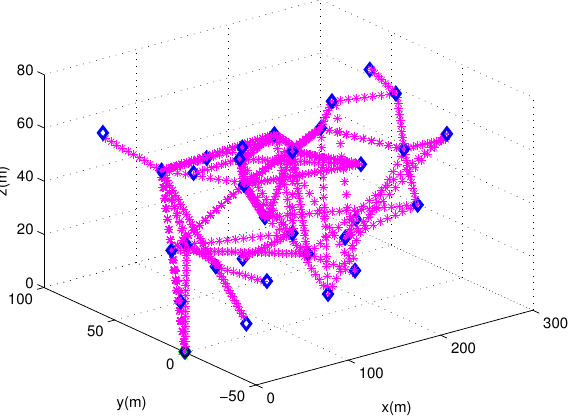
Figure 6. The path of each maneuvering AR until the user-specified box is entirely covered ( r sc = 50 m). The path of a maneuvering AR is depicted with magenta line segments. The final position of a maneuvering AR is depicted as a blue diamond. See that blue diamonds are marked at end points of each line segment.